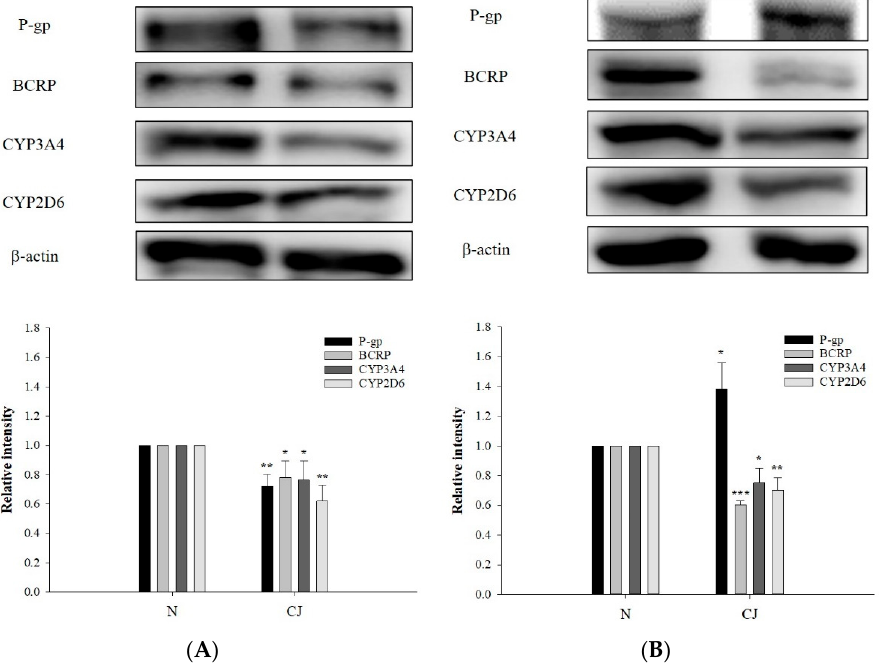
Figure 5. Protein levels (mean ± S.D.) of P-gp, BCRP, CYP3A4 and CYP2D6 in enterocytes ( A ) and hepatocytes ( B ) after ingestion of water (N, n = 3) and CJ (5.0 g/kg) (n = 3). * p < 0.05, ** p < 0.01 and * ** p < 0.001 .